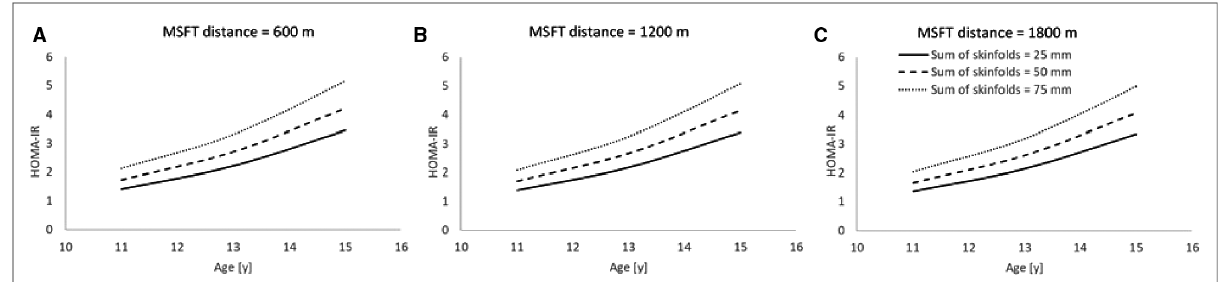
FIGURE 4 The combined model to best explain HOMA-IR ( n =45). Modelled data for both distance run on MSFT and sum of skinfolds, where distance run on MSFT is 600 m ( Figure 4A ), 1,200 m ( Figure 4B ) and 1,800 m ( Figure 4C ). (Main effect of sum of skinfolds, p =0.052; main effect of distance run on the MSFT, p =0.004). Hypothetical data displayed are mean±1 SD for both sum of skinfolds and